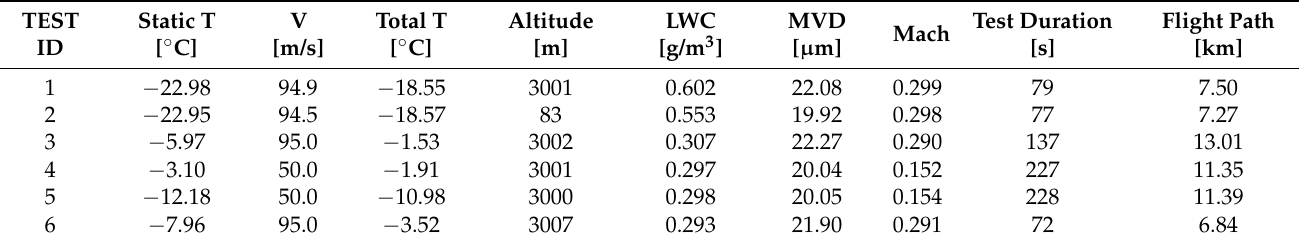
Table 3. IWT test